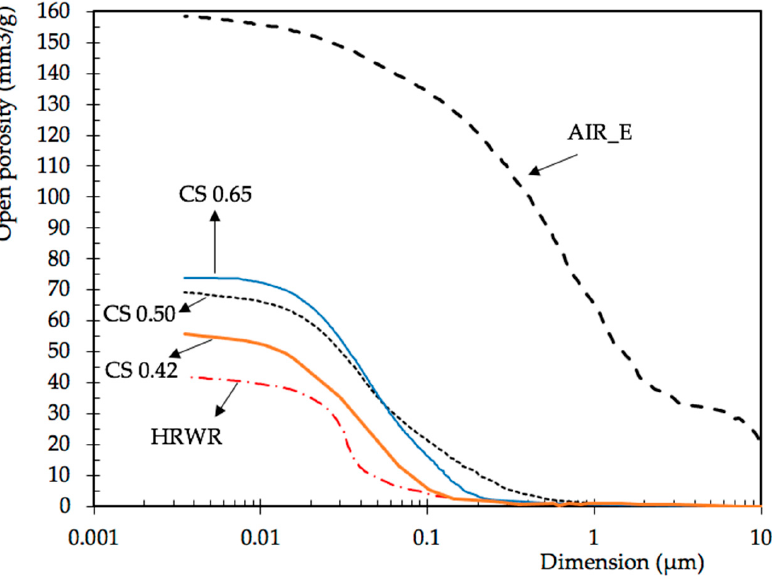
Figure 1. MIP porosity of 2B mortars cured at 7 days.